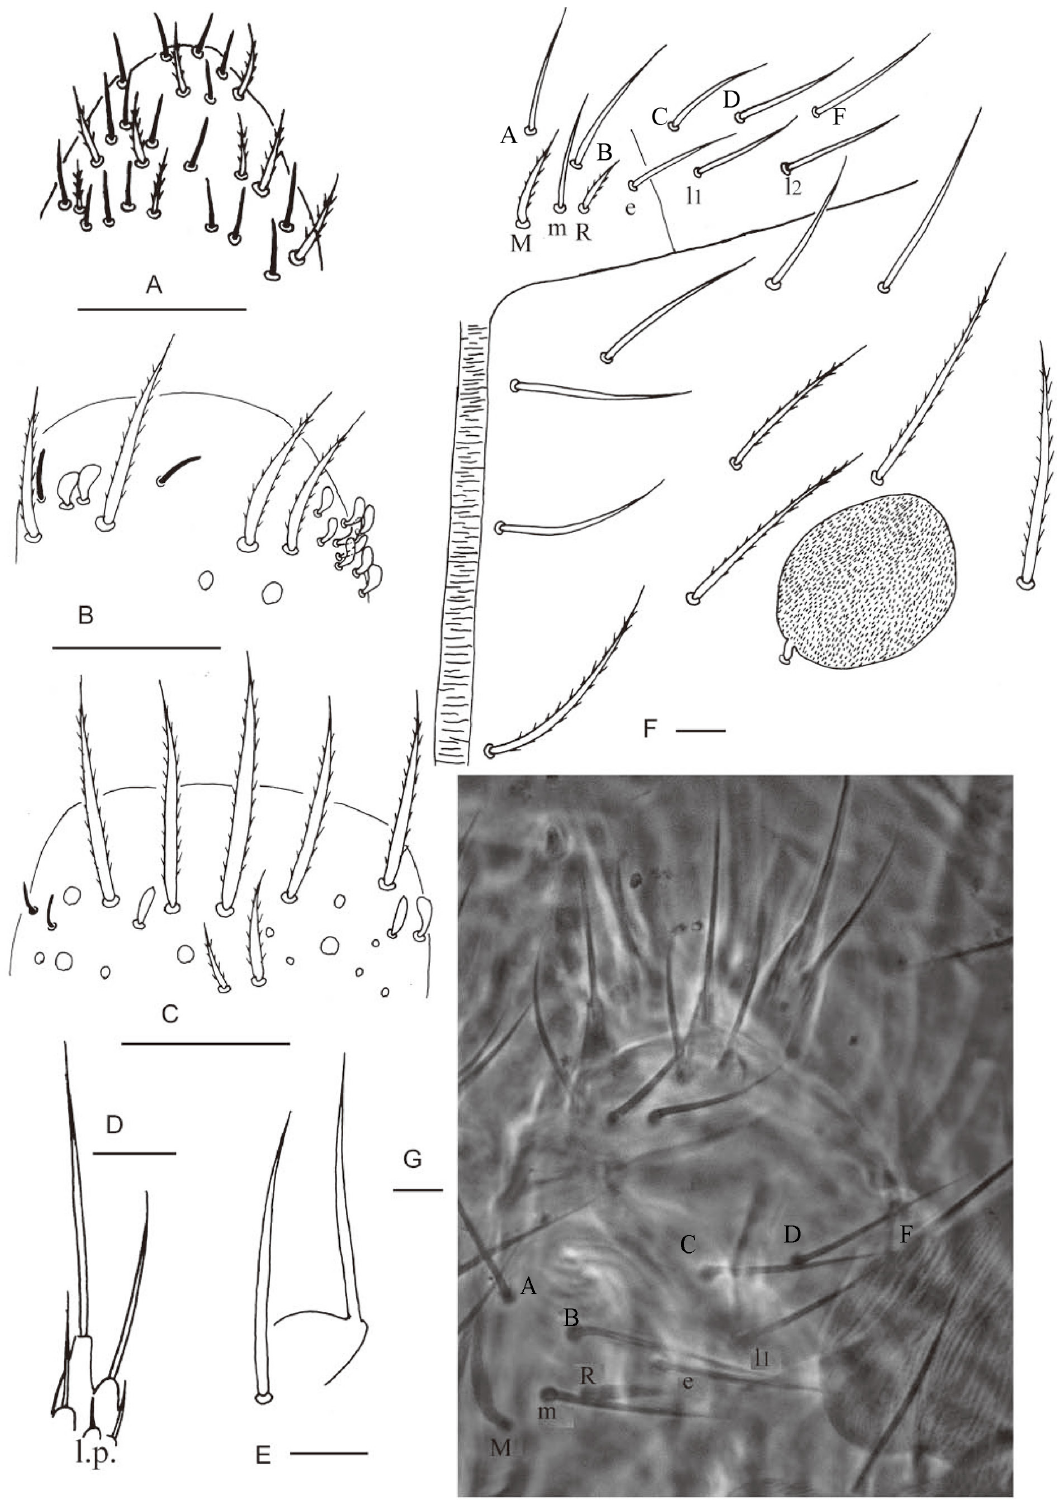
Fig. 2. Lepidocyrtus ( A. ) huizhouensis sp. nov. A . Apex of Ant. IV (left side). B . Distal part of Ant. III (lateral side). C . Distal part of Ant. II (left side). D . Lateral process of labial palp (right side). E . Maxillary outer lobe (left side). F . Labial and mental chaetotaxy (right side). G . Labial palp and labium (right side). Scale bars: 20